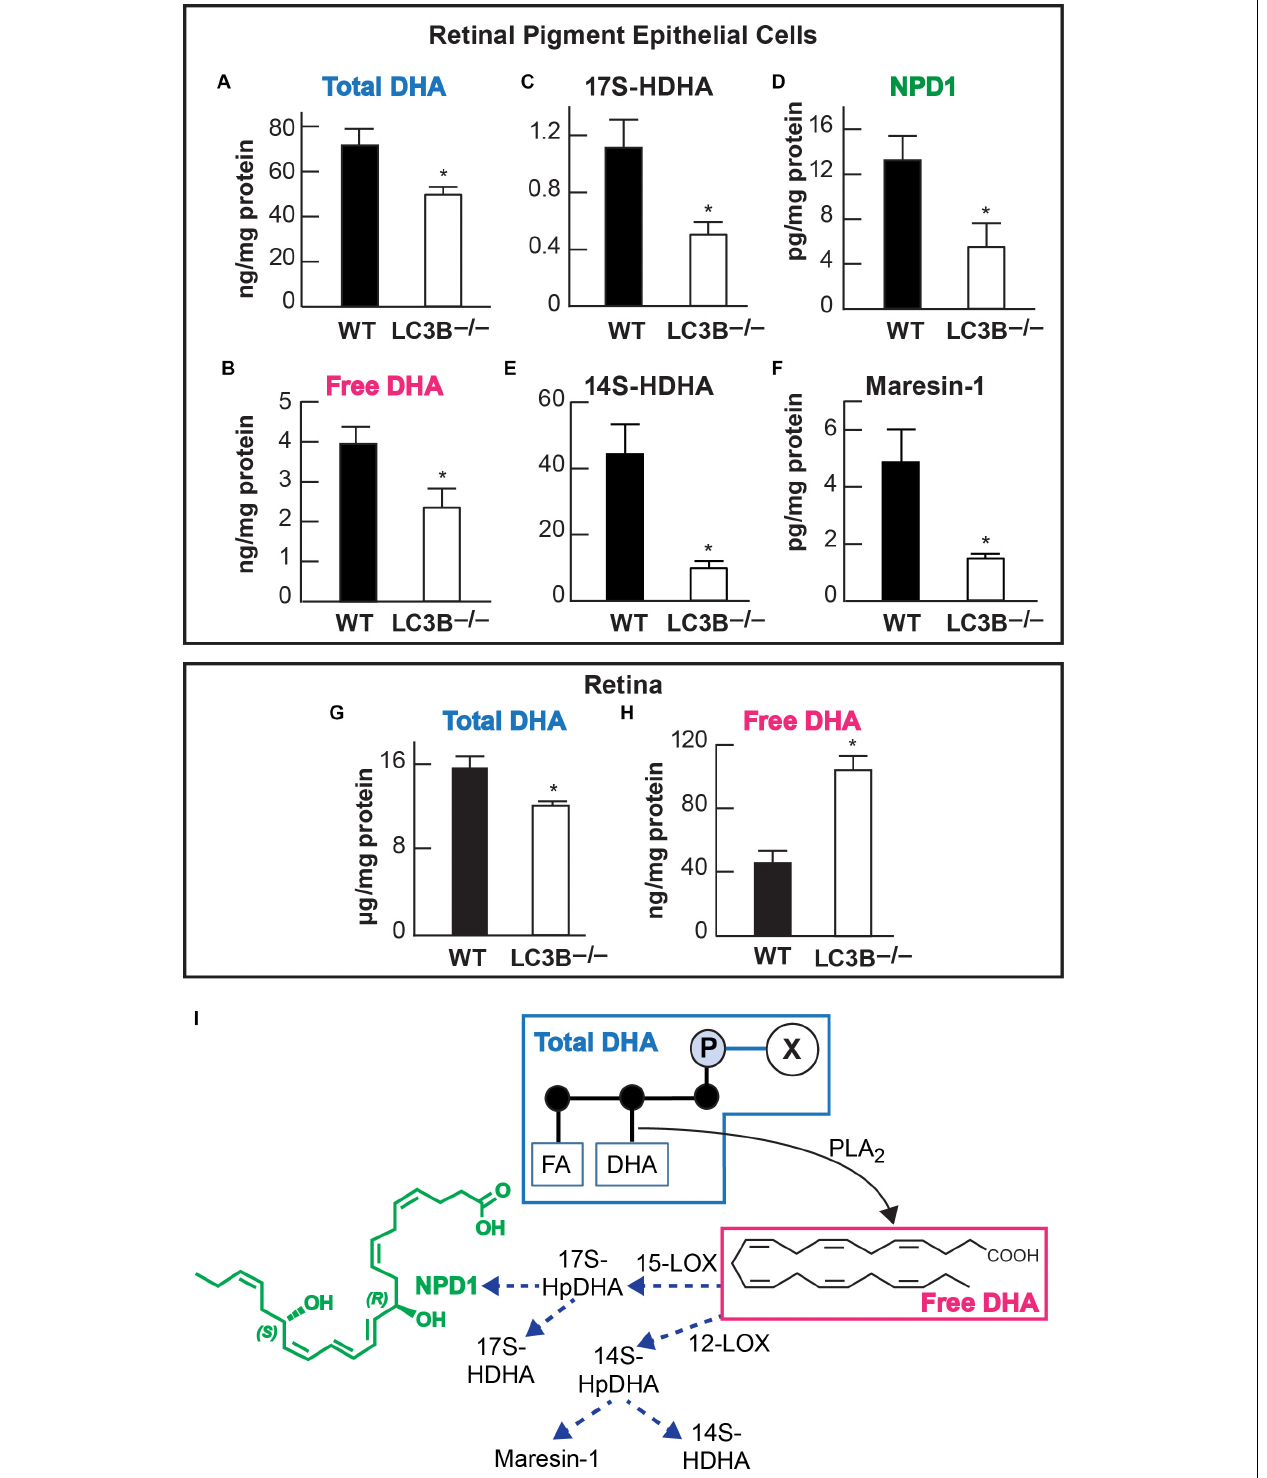
FIGURE 5 | Relative abundance of DHA (docosahexaenoic acid) and of docosanoids in retinal pigment epithelial cells (RPE/choroid) and in retina of wild -type and LC3B − / − . In retinal pigment epithelial cells (RPE/choroid): Esterified DHA (total) (A) ; free DHA (B) ; 17(S)-HDHA (C) ; NPD1 (D) ; 14(S)-HDHA (E) , and Maresin-1 (F) . In retina total (G) and free (H) DHA. Data obtained by LC/MS/MS lipid profiling. ∗ p < 0.050. Mice were 18–20 months old. The diagram (I) depicts a phospholipid hydrolyzed by a PLA2 that releases DHA. In turn two paths for the formation of docosanoids are illustrated, one leading to NPD1 and the other to maresin-1.